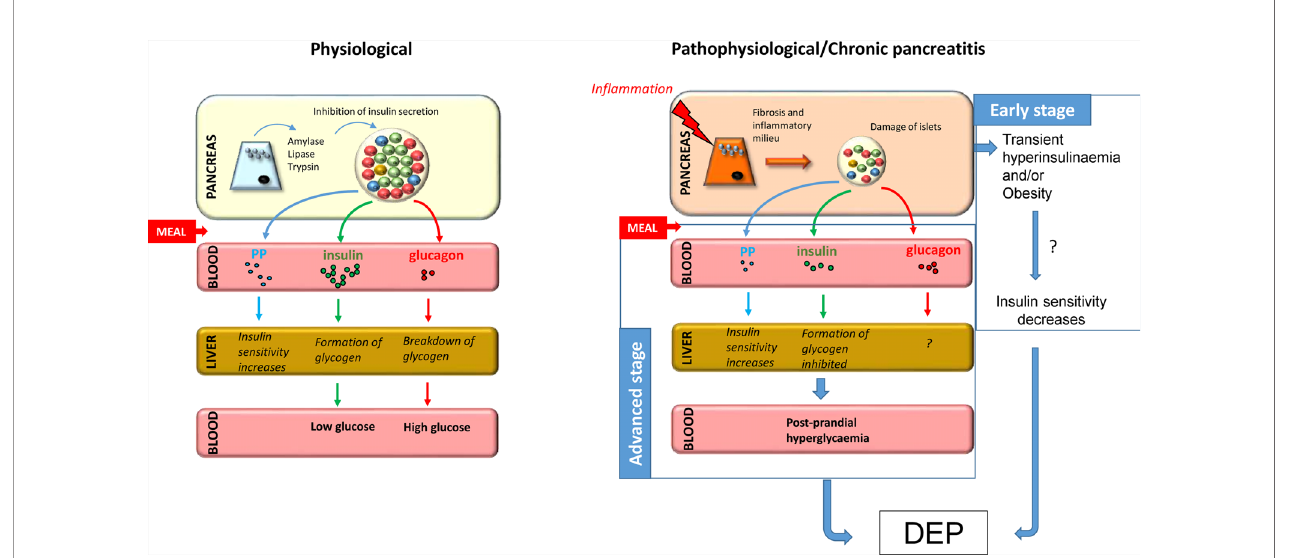
FIGURE 1 | Putative mechanism for the development of DEP in CP. Under normal conditions, food ingestion triggers secretion of enzymes from acinar tissue, insulin from beta cells, and pancreatic polypeptide from PP cells and inhibits secretion of glucagon from alpha cells. In chronic pancreatitis, fi brosis and in fl ammatory milieu lead to destruction of islets and decreased hormone production, especially insulin and pancreatic polypeptide, resulting in decreased glycogen formation and increased hepatic IR, respectively. Taken together, this leads to post-prandial hyperglycaemia and predisposes patients to the development of diabetes at advanced stages. Furthermore, the early stage of the disease is often associated with hyperinsulinemia, which together with obesity, may play a role in the development of IR, which is a known precursor to